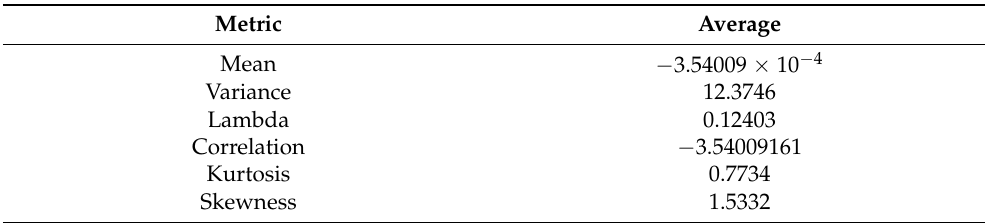
Table 2. Performance measures on the fuzzy enhanced